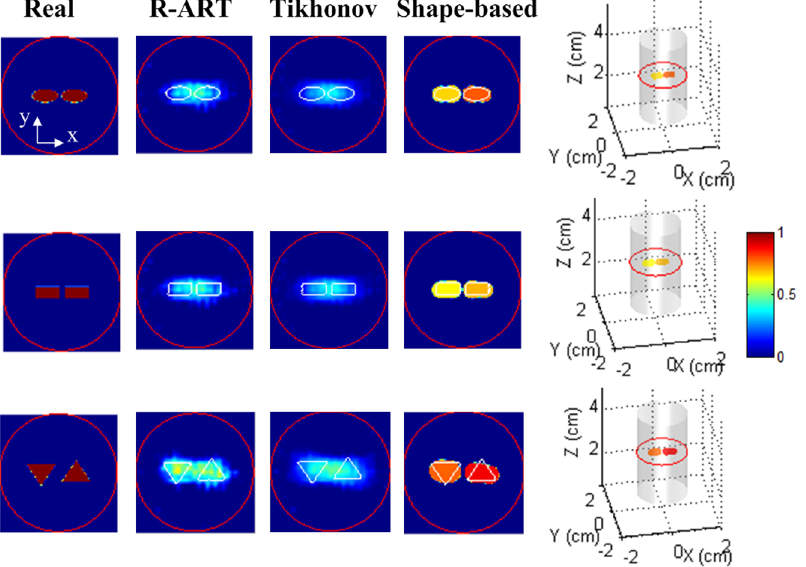
Figure 4. Comparison of the results from the proposed method and voxel-based reconstructions. In the slice images, the red circles denote the outer boundary of the imaged object, and the white lines denote the boundaries of the real inclusions. The slice images are of 3.0 cm height.